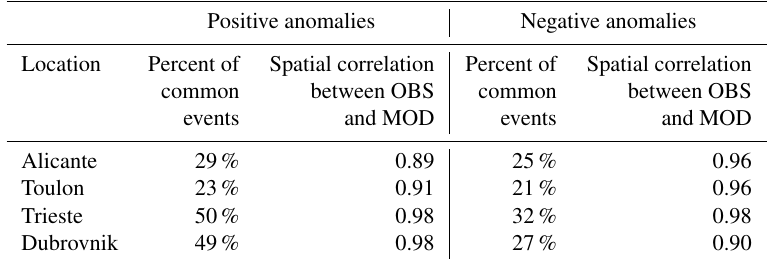
Table 1. Observed and modelled sea level anomalies. For each location the table reports the fraction of events that are common to the lists of observed and simulation events and the spatial correlation between the corresponding SLP composites. Positive anomalies Negative anomalies Location Percent of Spatial correlation Percent of Spatial correlation common between OBS common between OBS events and